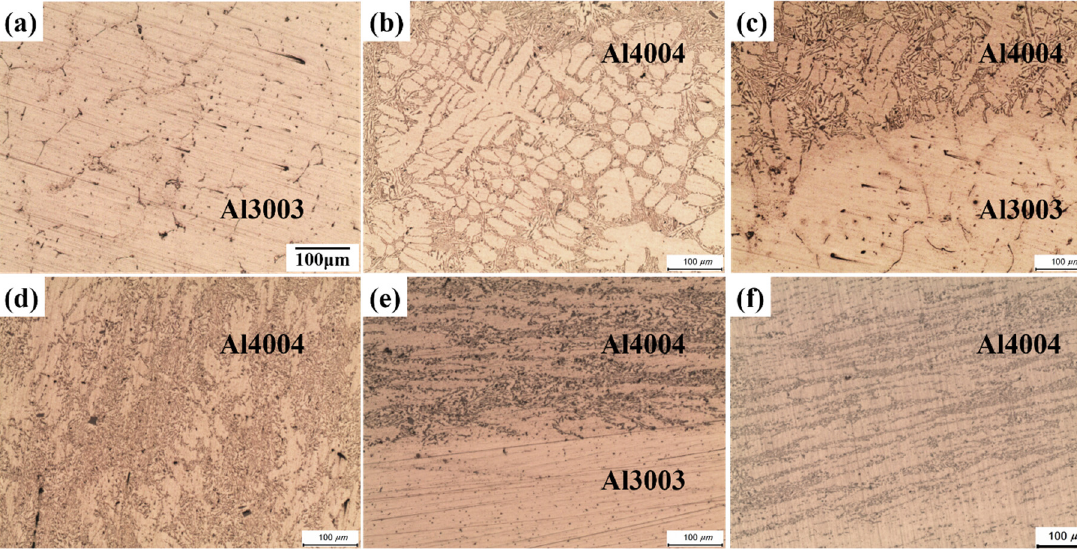
Figure 6. Microstructures of duo-casted Al3003/Al4004. Sampling positions ( a ) #1 in Al3003, ( b ) #2 in Al4004 before the extruding region, ( c ) #3 in Al3003/Al4004, ( d ) #4 in Al4004 of the round region, ( e ) #5 in Al3003/Al4004, and ( f ) #6 in Al4004 after extrusion (same magnification).